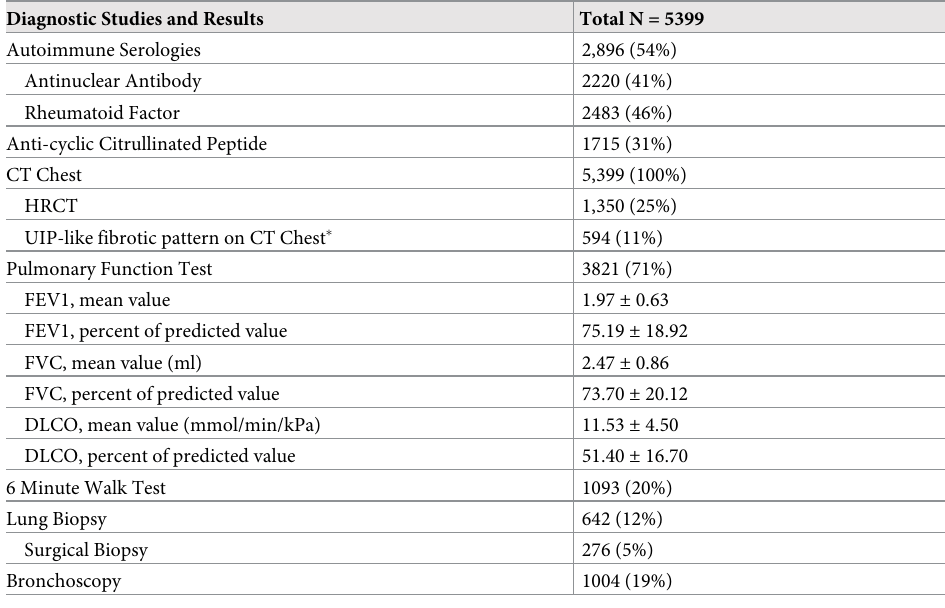
Values are mean ± SD of No. (%). � N = 5366. HRCT = high-resolution computed tomography; UIP = usual interstitial pneumonia; FEV1 = forced expiratory volume; FVC = forced vital capacity; DLCO = diffusing capacity of the lung for carbon